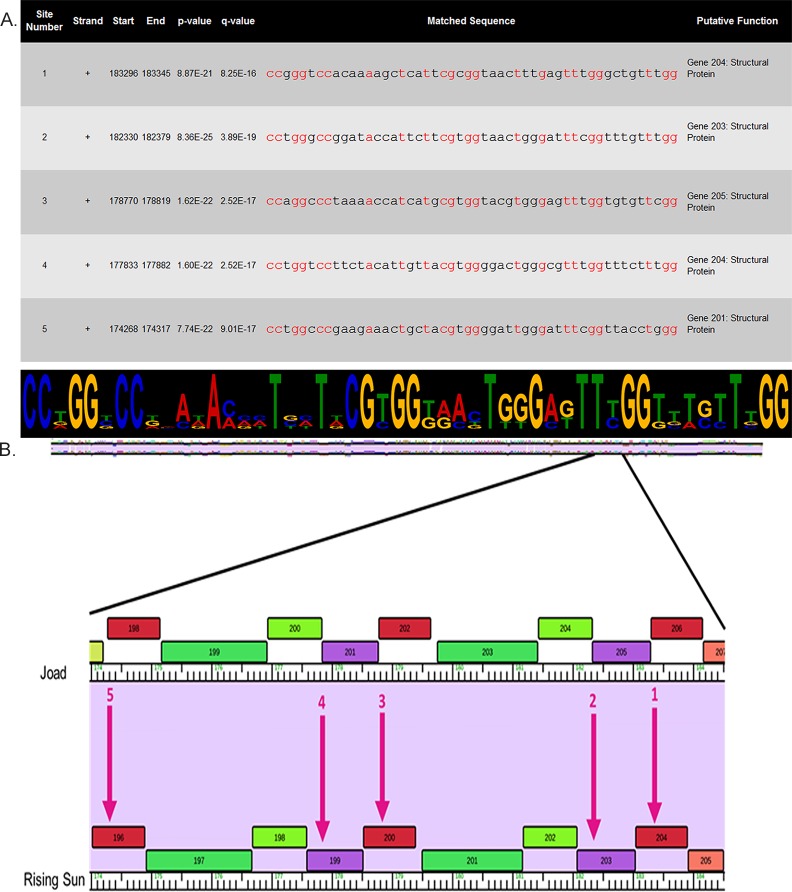
Locations of one motif discovered in five different structural genes.A) Exact location of motif sites, p and q-values, sequence of motifs (conserved nucleotides shown in red), and putative gene function. Logogram shows motif sequence and larger letters represent frequent conservation. B) Arrows show approximate location of motif site. Genes were analyzed from the RisingSun annotation and thus locations are shown in the RisingSun phamerator map.